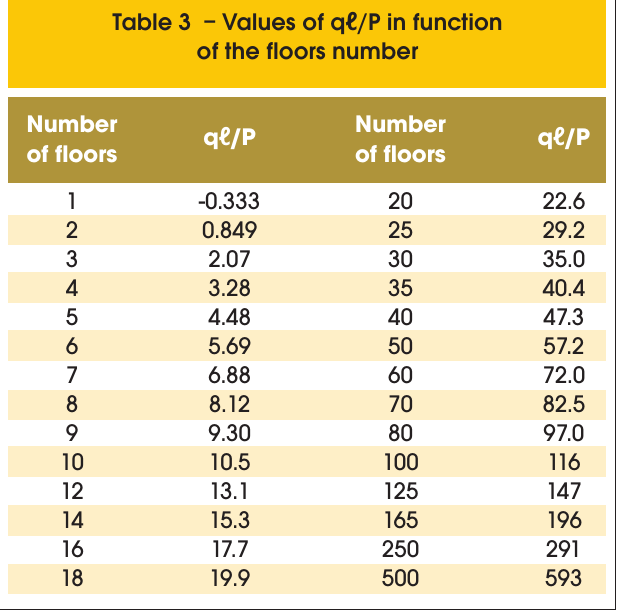
Table 3 – Values of q ℓ /P in function of the floors number